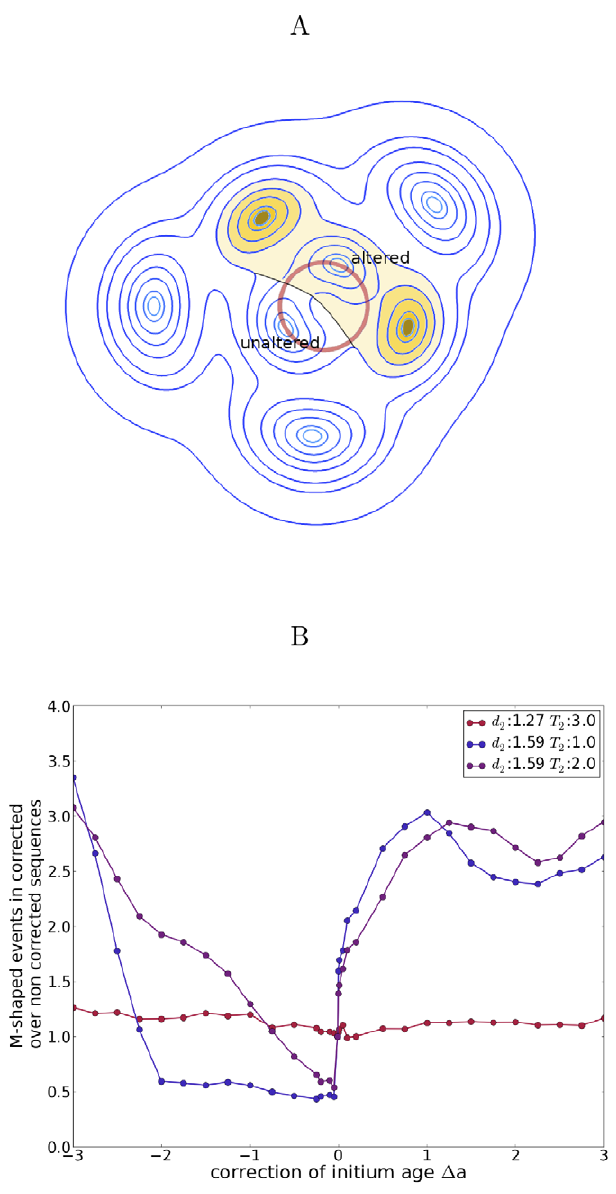
Figure 5. Noise correction by a secondary field. (A) After a time T 2 following initiation, each organ generates a secondary field of range d 2 (yellow region for the effect of the two younger primordia). When formed, an initium may be influenced by the secondary field. If so, its age is shifted by an amount D a . This results in a differential age shift between initia appearing concomitantly. (B) Relative variation in concomitant initiations as a function of the age shift D a for three points in the parameter space of the secondary field. Note that d 2 is measured relatively to the range of the primary field ( d 2 ~ 1 means the same range as the primary field).